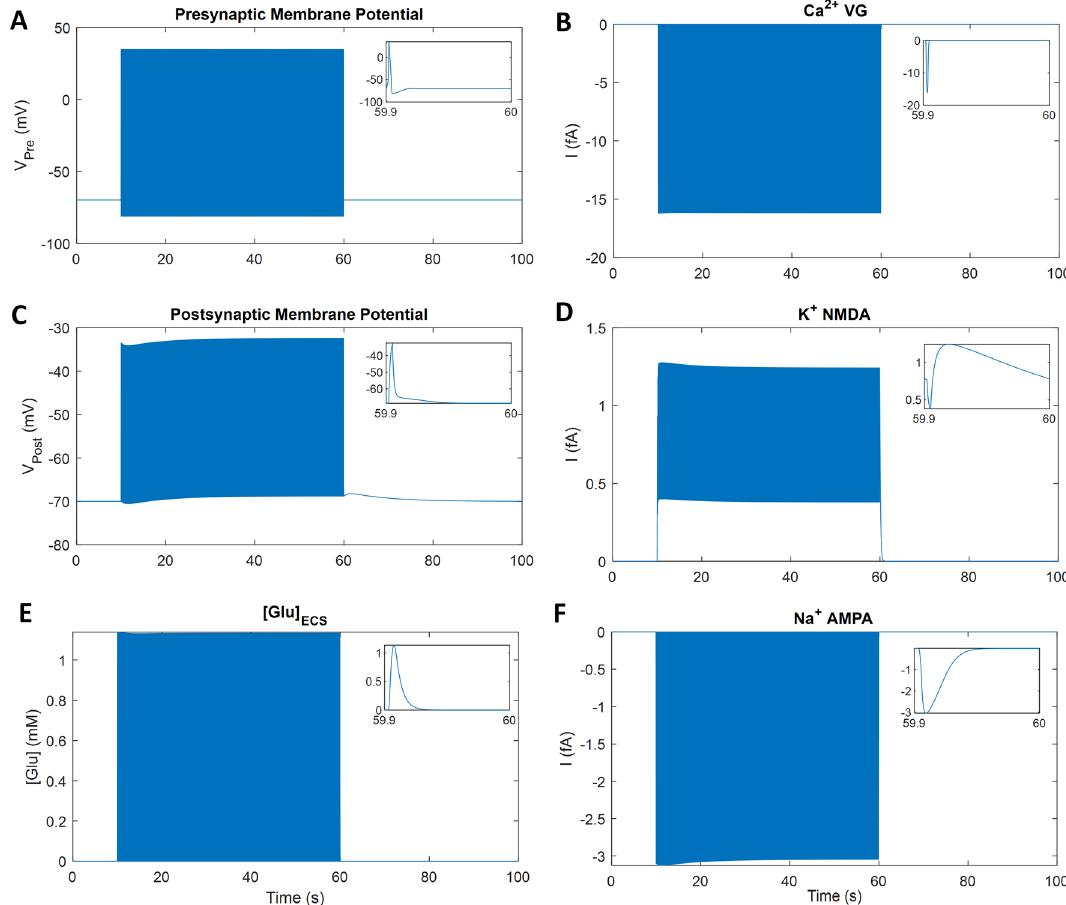
Figure 3. Simulation of neuronal activity. The inset shows the last 100 ms of the stimulus period. The action potential invades the presynaptic terminal, changing the membrane potential briefly ( A ), which allows the VGCCs to open ( B ) and subsequent Ca 2+ influx promotes the release of Glu into the cleft ( E ). Glu activates the AMPA-R ( F ) and NMDA-R ( D ) on the Post, which causes a small depolarisation of the membrane potential ( C